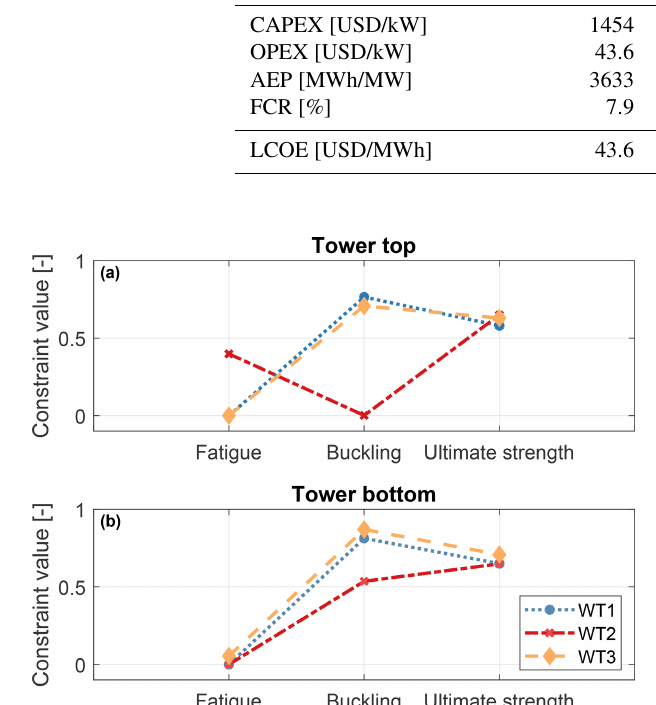
Figure 2. Design constraints at tower top (a) and tower bottom (b)